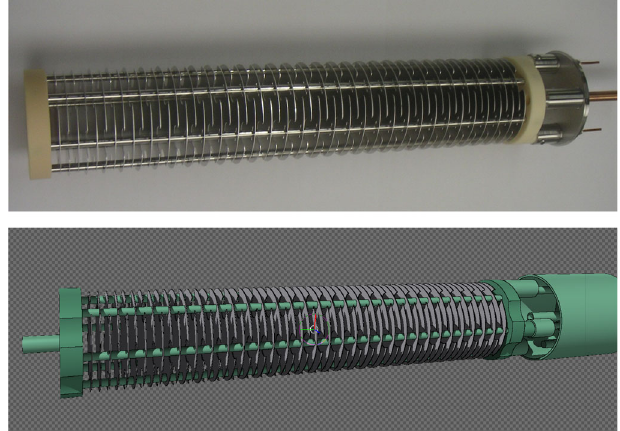
FIG. 2. Interior of a standard LHC beam loss monitor (top) and the corresponding FLUKA model used in the particle shower simulations (bottom). The 61 aluminum electrodes are connected by means of stainless steel rods, which are supported by thick alumina plates on both ends of the